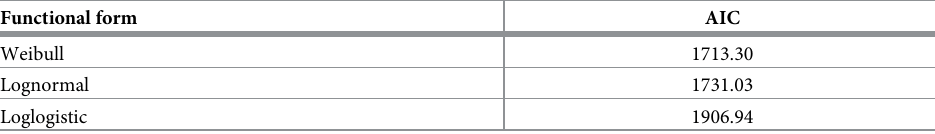
Table 5. AIC scores of three alternate forms of parametric survival